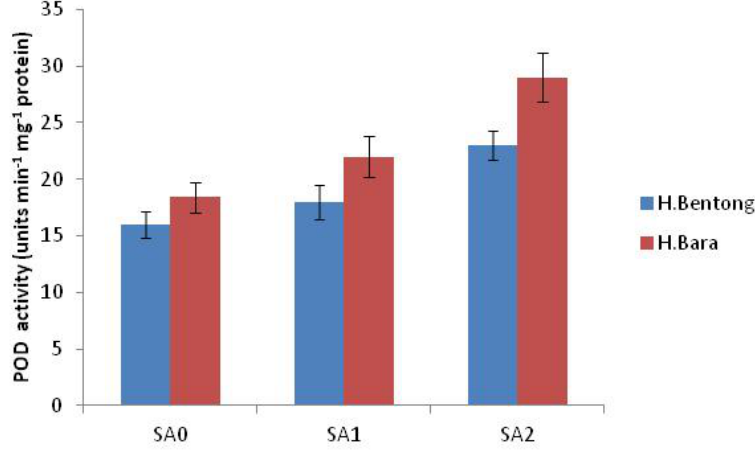
Figure 4. Peroxidase activity in Halia Bentong and Halia Bara treated with different concentrations of SA (SA0: control; SA1: 10 –3 M; SA2: 10 –5 M).